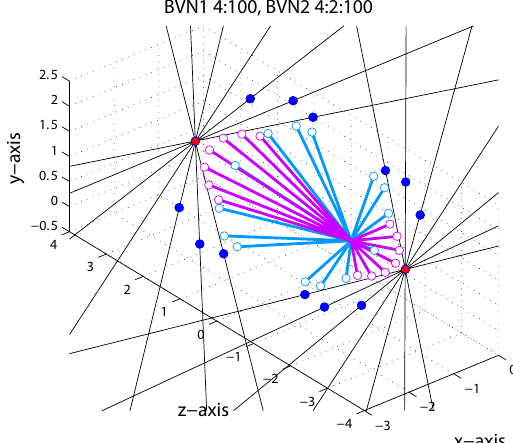
Figure 8. Model predictions for line stimuli in Exp. 2. Each of the seven black hairlines corresponds to a constraint (ICP) for an upwards trajectory to the left and away from the observer ( − IOVD/far) and to the left and towards the observer (+IOVD/near). Red circles correspond to the cyclopean average (CA) and dark blue circles to vector normal (VN) predictions. Light blue and light purple open circles correspond to BVN1 and BVN2 predictions, respectively. See text for